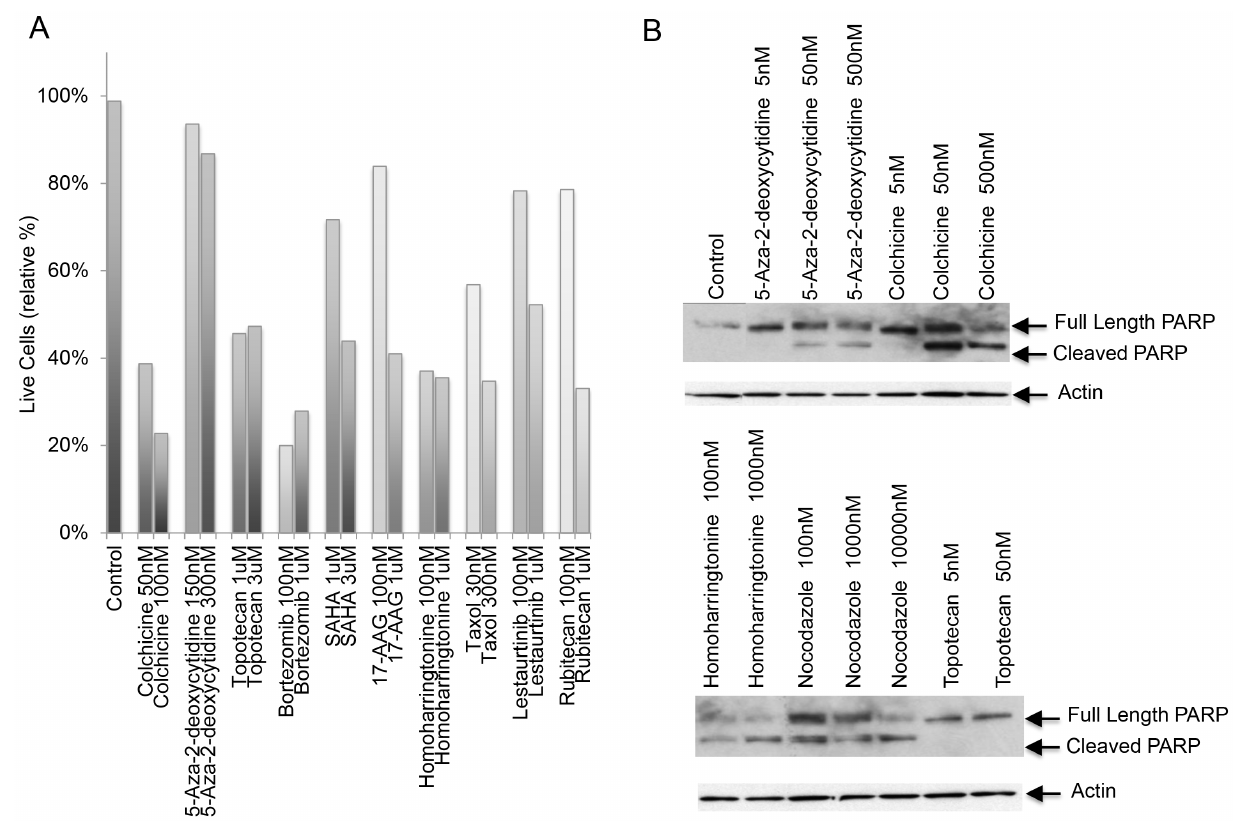
Figure 2. Apoptosis induced by screened drugs. A) To quantify viable cells, the membrane impermeable dye 7-amino actinomycin D (7-ADD) was added to a cell suspension of PC12 cells, after overnight treatment with the respective compound. The bar graph represents relative live cell percentage. B) MTT cells were cultured with the indicated drug and dose for 20 hr and total cell lysates were subjected to Western blot for full-length PARP, cleaved PARP and